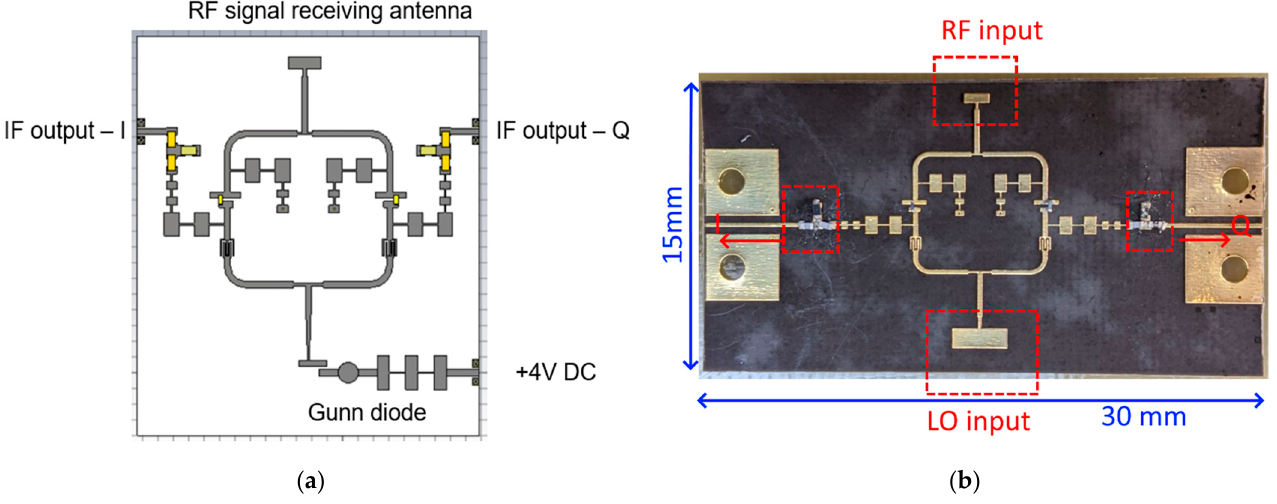
Figure 9. Schematics ( a ) and fabricated PCB board ( b ), containing IQ subharmonic mixer for 110 GHz with antennas for 55 GHz LO oscillator and ~110 GHz input signal with output patch antennas.